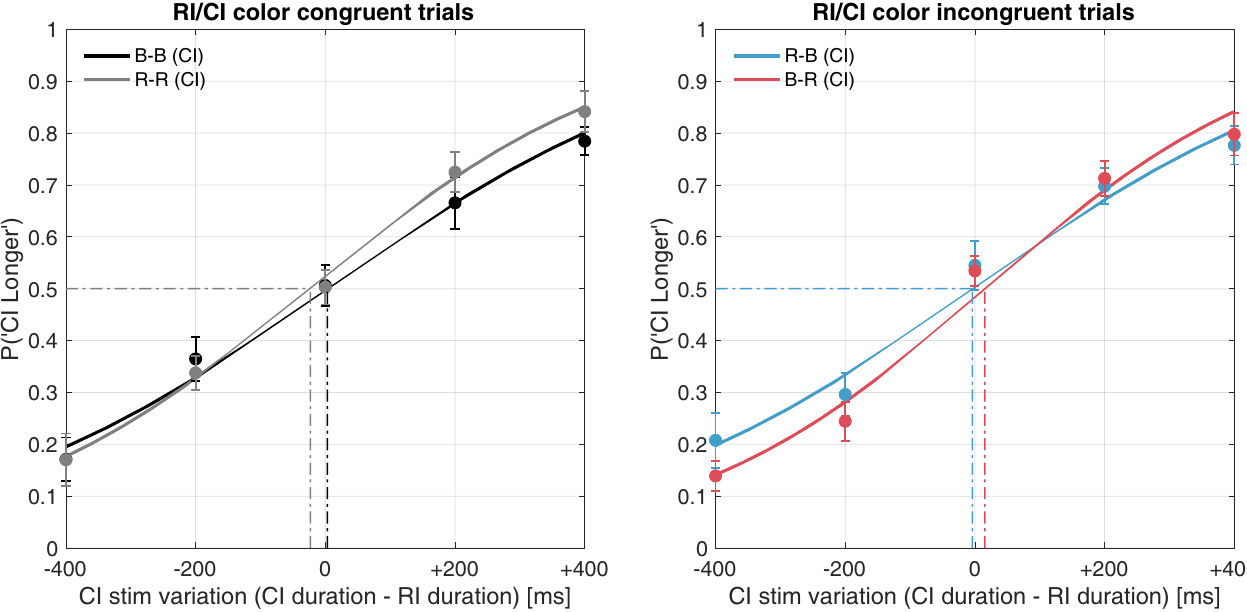
Fig 7. Mean psychometric functions (PLR-based equiluminance). Left panel: Psychometric function fitting according to the proportion of comparison interval–longer (CI) responses in congruent color sequence. Right: For incongruent color sequence. Abbreviations: B–blue, R–red, CI–comparison interval, RI–reference